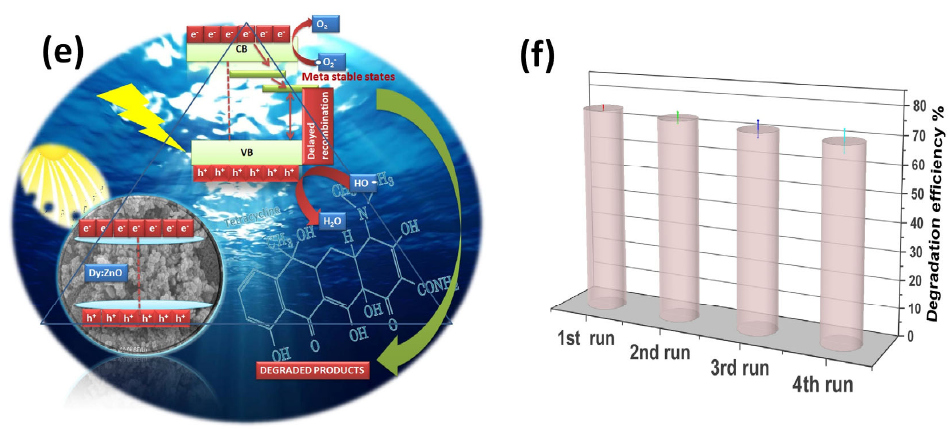
Figure 11. ( a ) Effect of TC concentration on photodegradation efficiency, ( b ) Effect of catalyst dosage on photodegradation efficiency of Dy doped ZnO nanoparticles, ( c ) C t /C 0 graph for degradation of TC in a 120 min experiment (reaction conditions: catalyst dosage: 25 mg, drug concentration: 20 mg/L, temperature: 20 ± 5 °C), ( d ) Calculated removal efficiency in the presence of various scavengers, ( e ) Schematic of plausible mechanism for the degradation of TC, ( f ) Reusability and sustainability analysis of Dy doped ZnO catalyst.